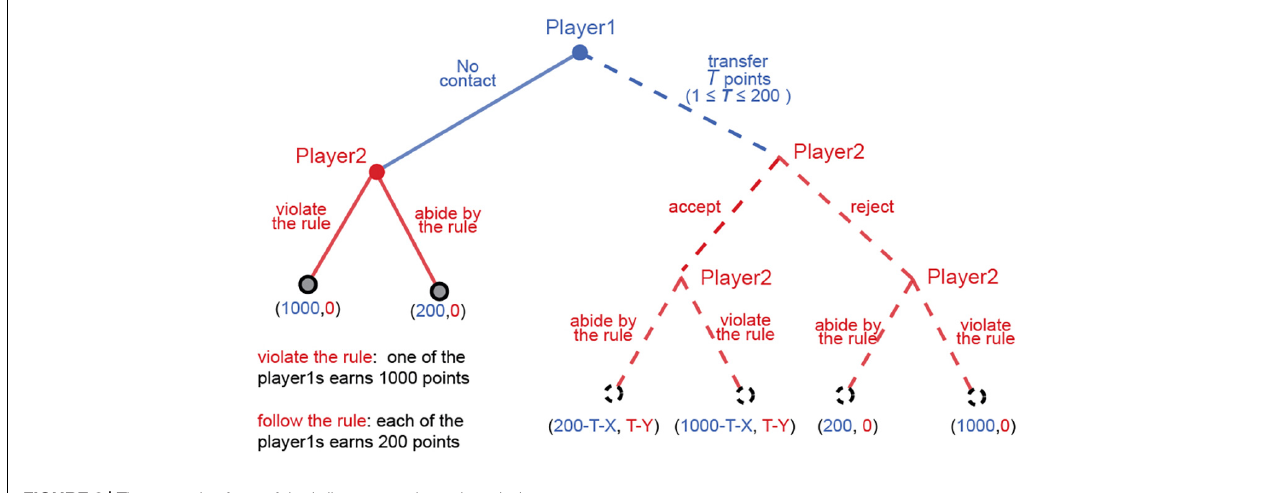
FIGURE 2 | The extensive form of the bribery game in each period. Table 1 | The contexts and vocabulary used in the three treatments. Treatments Familiar